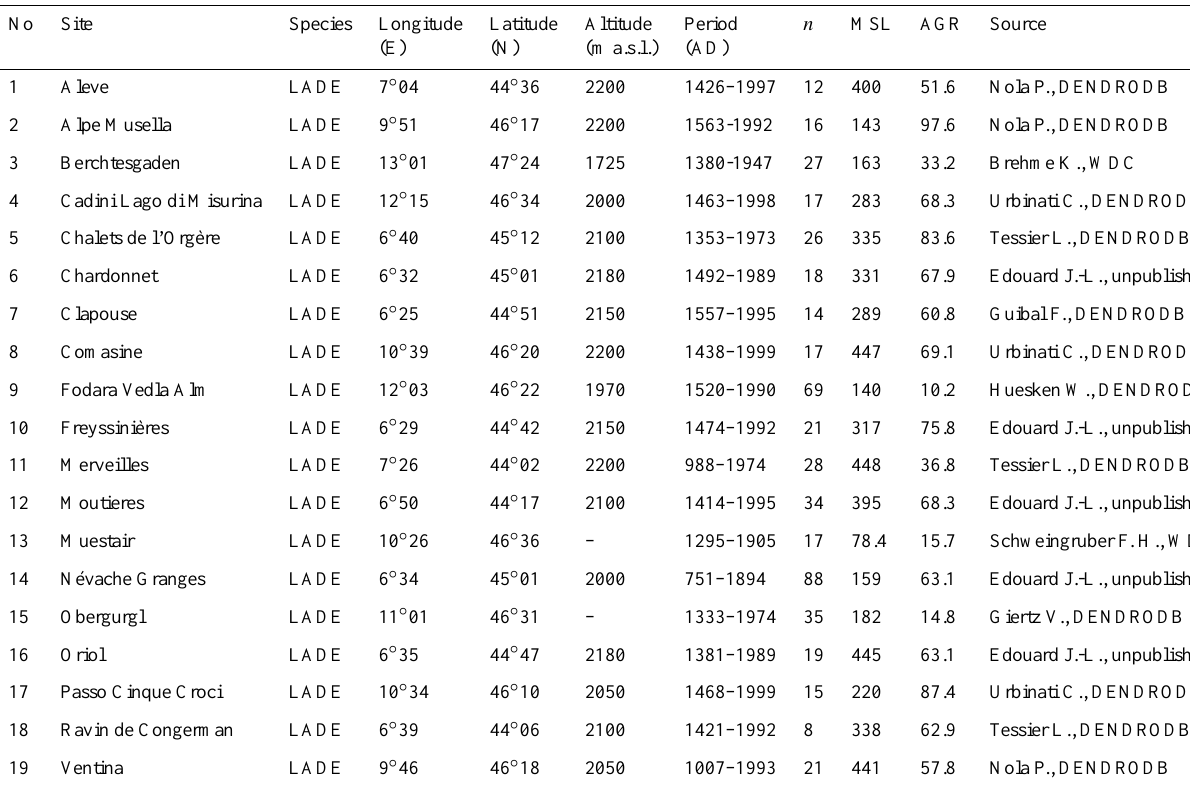
Table 1. Characteristics of the tree-ring sites: identifier (No), site name (TRW: Tree Ring Width, MXD: Maximum Latewood Density), location, species (LADE: Larix decidua ; PICE : Pinus cembra ), period covered before truncation due to low replication (see details in Sect. 3.1), number of individual tree-ring width series ( n ), Mean Serie Length (MSL in years), Average Growth Rate (AGR in 1/100mm/year) and source (DENDRODB: http://servpal.cerege.fr/webdbdendro; WDC: http://www.ncdc.noaa.gov/paleo/treering.html). The identifiers are the same as in Fig.